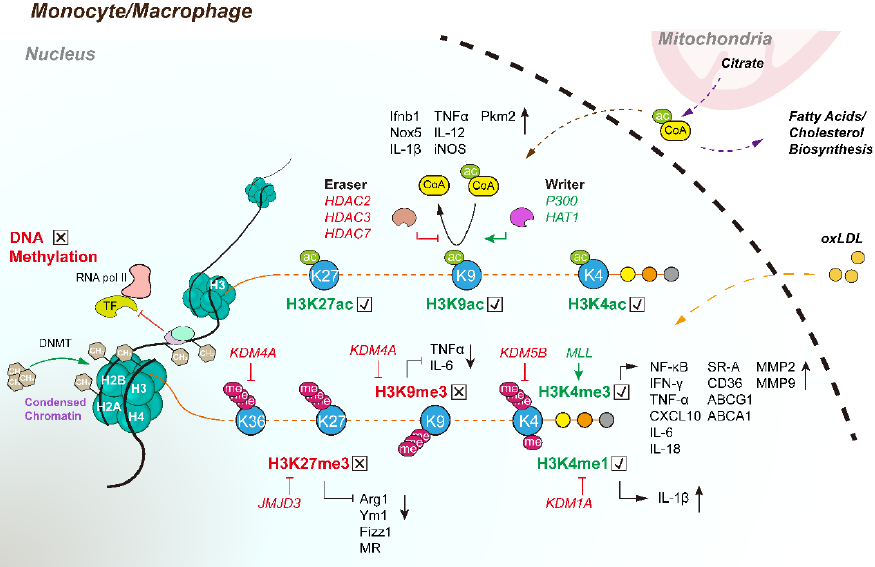
Figure 3. Epigenetic modifications of atherogenesis-related genes regulated by “Writer” and “Eraser” in monocytes/macrophages. DNA methylation can be regulated by DNA methyltransferase (DNMT), which increases the negative charge of DNA through increased CH 3 − , thereby leading to condensed chromatin. It can also attract proteins to specifically bind and modify DNA, indirectly repelling the access of transcription factors to DNA binding sites. Histone methylation can either trigger or suppress the transcription of target genes. Most atherogenesis ‐ related genes are modified by H3 histone methylation and acetylation, which can be dually regulated by writers (e.g., MLL, p300, and HAT1) and erasers (e.g., KDM4A, KDM5B, KDM1A, JMJD3, and HDACs). Citrate can convert to acetyl CoA as an acetyl donor for histone acetylation and fatty acid and cholesterol bio ‐ synthesis. H3K4me1, H3K4 monomethylation; H3K4me3, H3K4 trimethylation; H3K4ac, H3K4 acetylation; MLL, mixed ‐ lineage leukemia, HAT1, histone acetyltransferases, KDM, histone lysine demethylase; JMJD3, jumonji domain ‐ containing protein 3, HDACs, histone deacetylases.